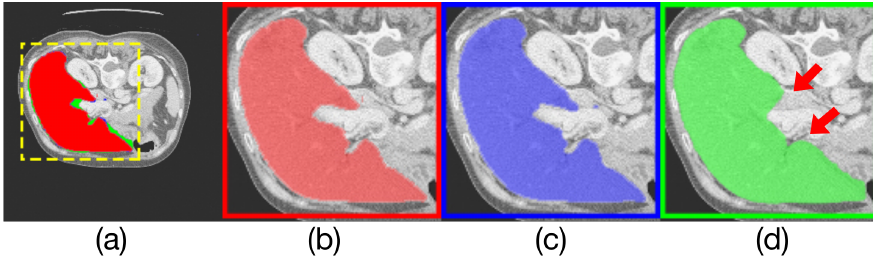
Figure 9. Comparison of model outputs and ground truth. ( a ) shows the other three figures stacked from top to bottom, where the predicted extra areas are clearly seen. The red area in ( b ) is the manually annotated result. The blue region in ( c ) is the output of Render U-Net. The green region in ( d ) is the output of Attention U-Net. Some areas with incorrect predictions are indicated with red arrows in the